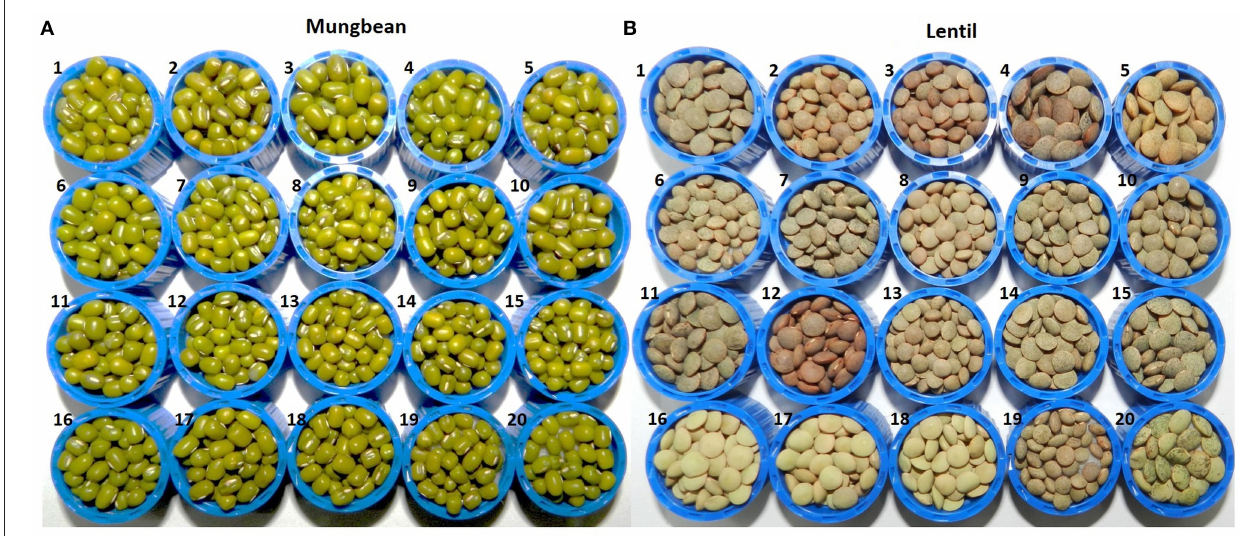
FIGURE 1 | Seed morphology details of 20 genotypes each of (A) mungbean and (B) lentils used in the study, where (A) mungbean genotypes are (1) Pusa Baisakhi, (2) Pusa Ratna, (3) Pusa Vishal, (4) Pusa105, (5) Pusa0672, (6) Pusa9072, (7) Pusa9531, (8) MH96-1, (9) MH318, (10) MH421, (11) MH521, (12) MH810, (13) ML512, (14) ML818, (15) PS16, (16) TM 96-2, (17) IPM02-3, (18) IPM02-14, (19) IPM409-4, (20) PMR1; while (B) lentil genotypes are (1) L4076, (2) L4147, (3) L4594, (4) L7903, (5) HM1, (6) BM4, (7) JL1, (8) Sehore74-3, (9) NDL1, (10) IPL81, (11) IPL321, (12) K75, (13) KLS218, (14) DPL58, (15) DPL62, (16) PL1, (17) PL2, (18) PL6, (19) L830, (20)